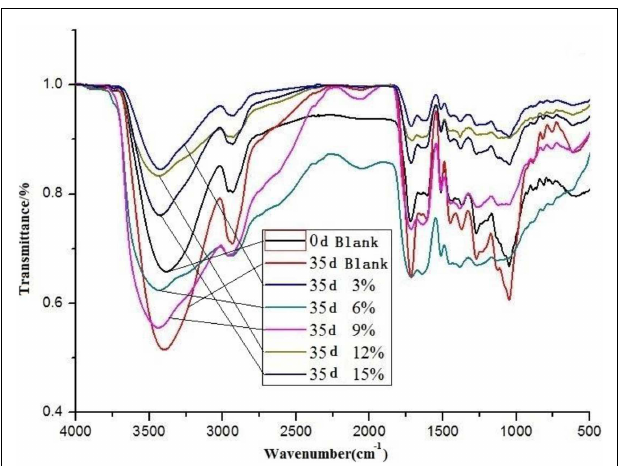
FIGURE 2 |The infrared spectra of bio-oil samples with different content of ethyl acetate